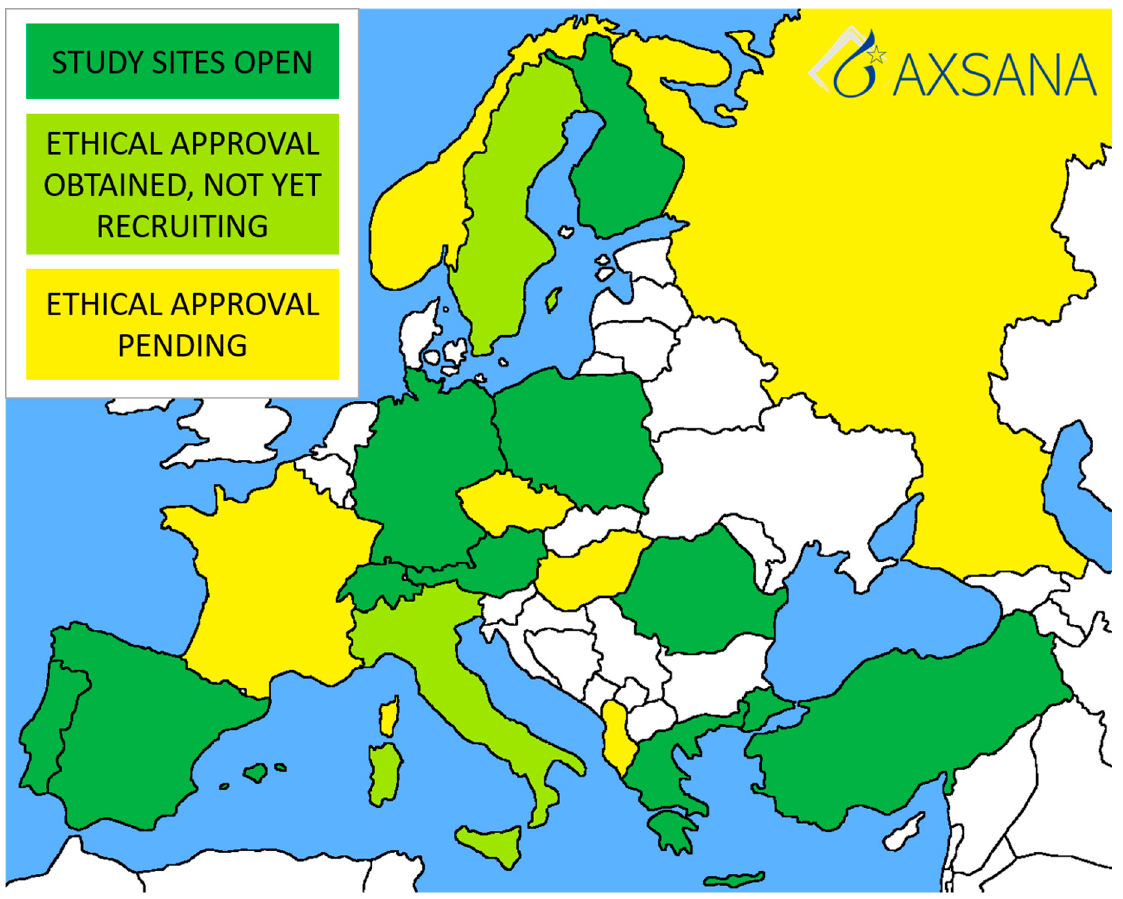
Figure 2. Current status of the AXSANA